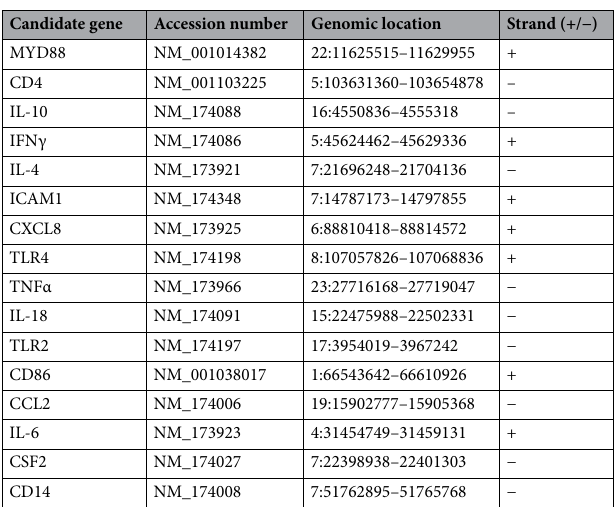
Table 1. List of candidate bovine mastitis genes and their accession number, genomic location, and strand type.